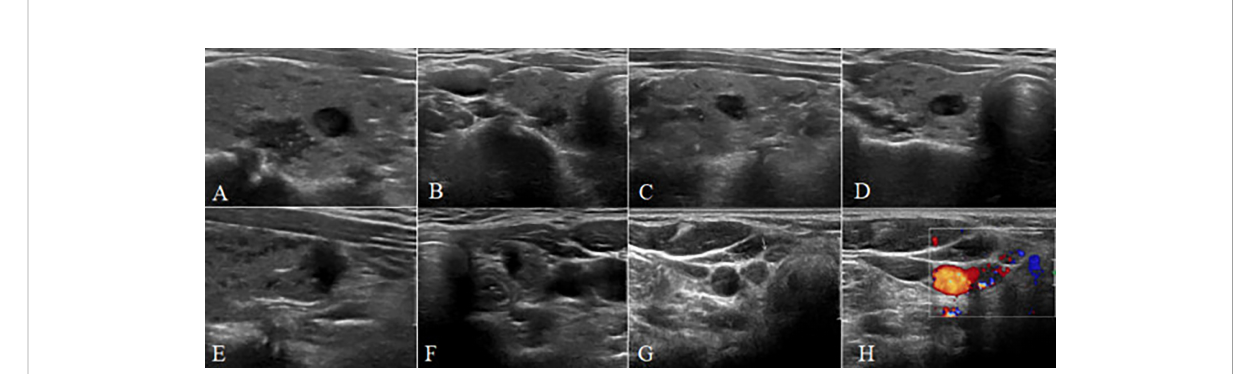
FIGURE 1 A 38-year-old female patient with multiple papillary thyroid carcinoma and large-volume CCLNM. (A – F) The longitudinal and transverse gray- scale sonogram of the tumor. (A, B) A bilateral nodule (11 mm × 9 mm × 6 mm) with irregular shape, spiculated margin, A/T < 1, close to capsule, away from trachea, and microcalci fi cation. (C, D) A bilateral nodule (7 mm × 8 mm × 5 mm) with irregular shape, spiculated margin, A/ T < 1, away from capsule, and away from trachea. (E, F) A bilateral nodule (8 mm × 5 mm × 8 mm) with irregular shape, ill-de fi ned margin, A/T > 1, capsule interruption, and close to trachea. (G) The gray-scale sonogram of central lymph nodes showing round-like nodes without normal structure (arrows). (H) The color sonogram of central lymph nodes showing abundant blood supply with irregular distribution. CCLNM, central cervical lymph node